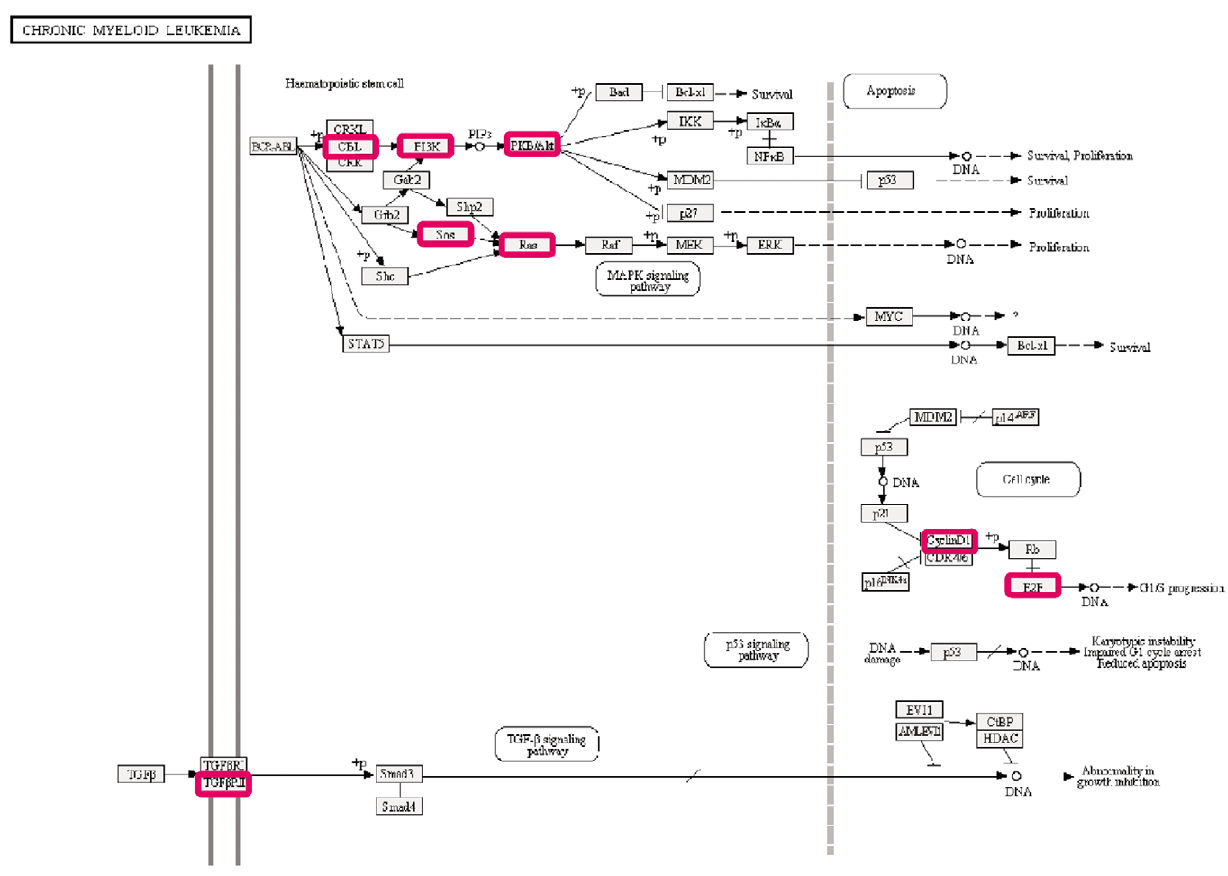
Figure 6. KEGG pathways of deregulated miRNAs predicted targets in CML. This figure presents cell survival and growth signaling pathways within a CML cell. Red squares represent proteins encoded by genes targeted by the deregulated miRNAs. We have shown that the miRNAs regulating these target genes are downregulated in CML. As a result, these target genes are probably upregulated leading to increased cell survival and induced of uncontrolled cell proliferation.